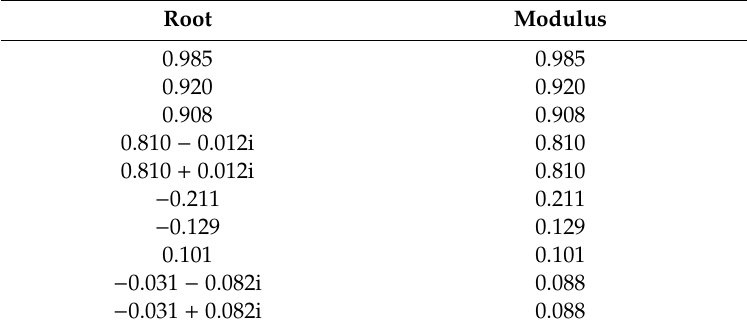
Table 1. VAR stability condition.